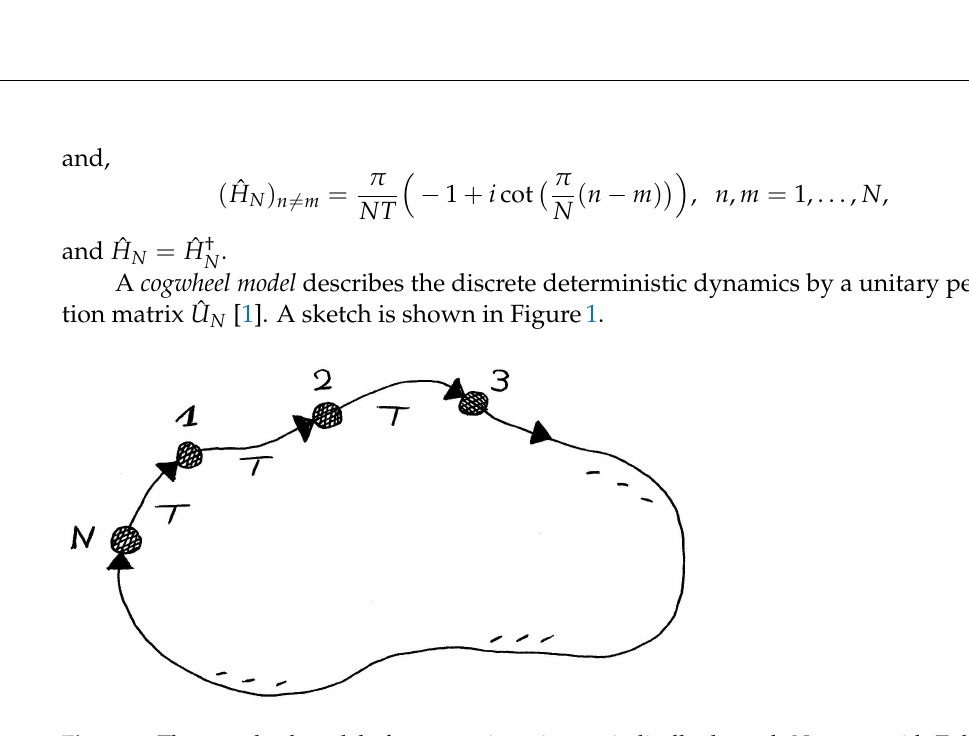
Figure 1. The cogwheel model of a system jumping periodically through N states, with T denoting the time it takes per